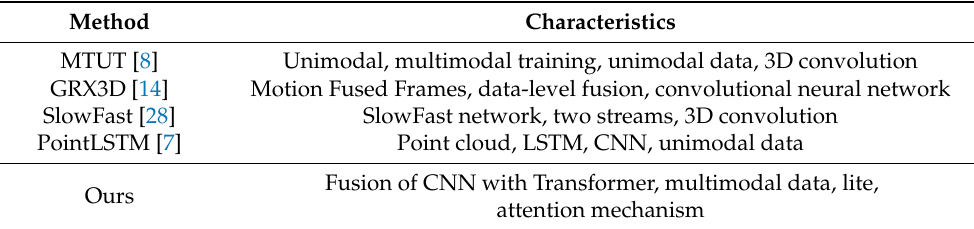
Table 7. Comparison of our method with other